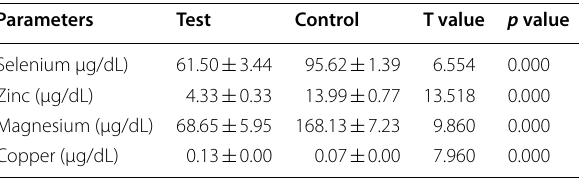
Table 4 Serum trace elements among prostate cancer patients and controls